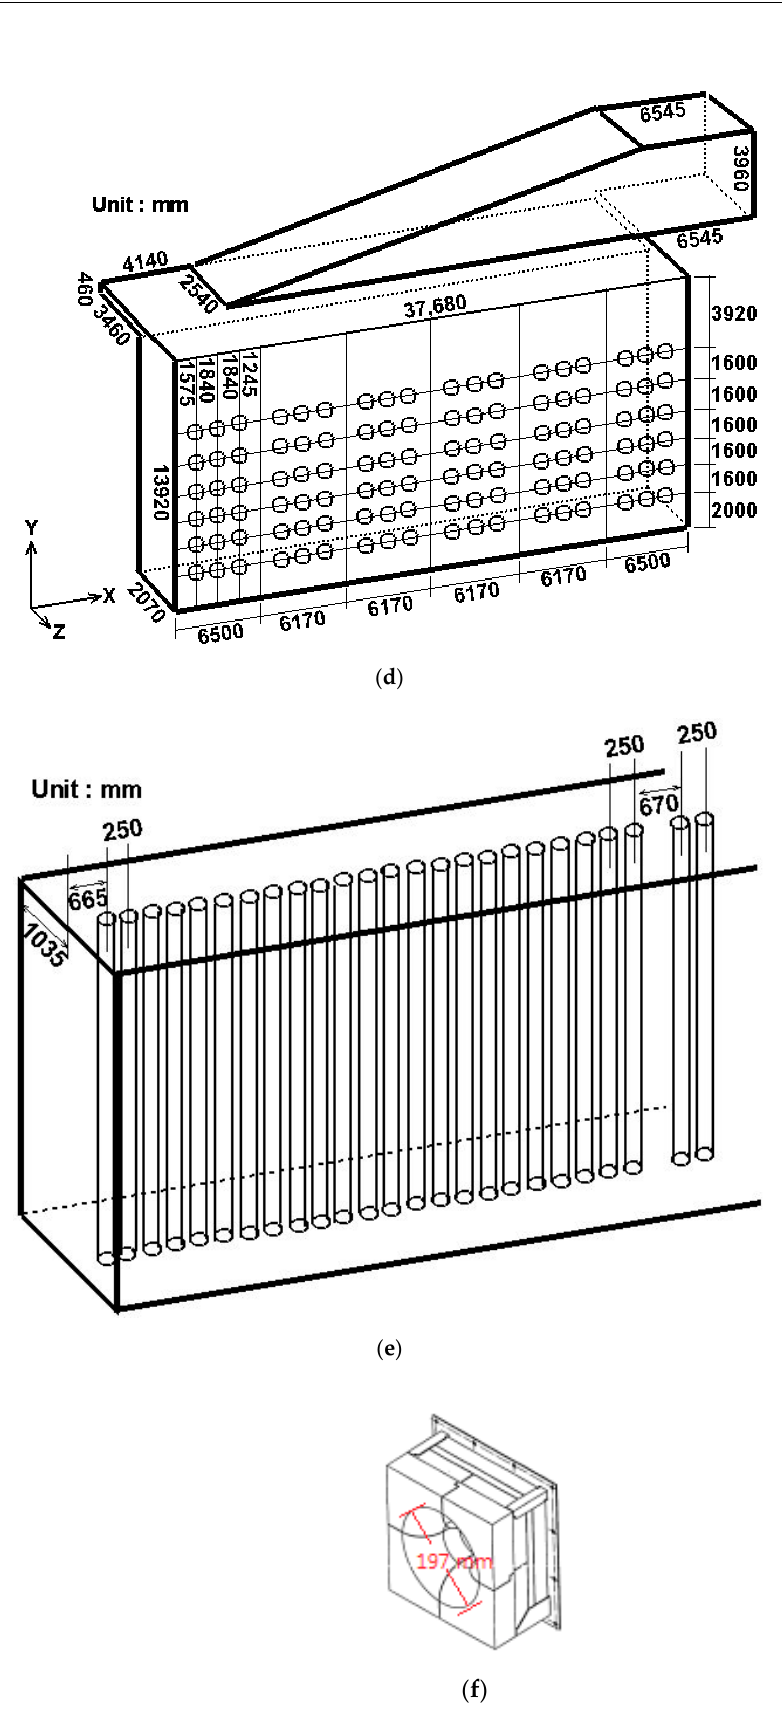
Figure 1. Steam methane reformer investigated: ( a ) Reformer configuration; ( b ) Reformer numeri- cal model; ( c ) Simplified model containing one group of catalyst tubes and burners; ( d ) Reformer dimensions and burner positions; ( e ) Catalyst tube positions; ( f ) Burner configuration.